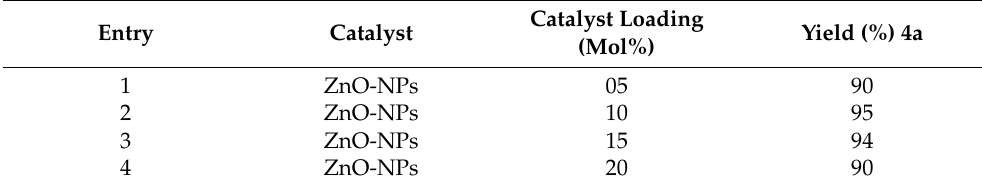
Table 1. Optimization of the catalyst (ZnO-NPs)